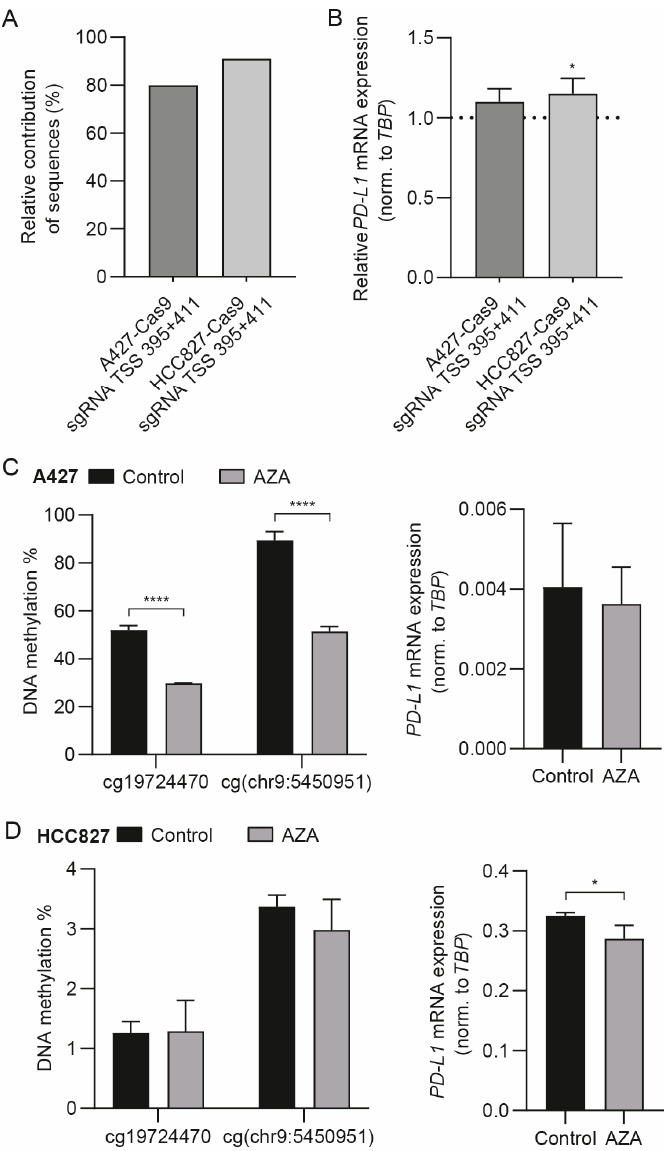
Figure 3. PD-L1 mRNA expression following alteration in genome-wide DNA methylation by aza- cytidine (AZA). (A,B) The consequence of a PD-L1 deletion harboring cg19724470 and cg(chr9:5450951). (A) The relative contributions of sequences with the deletion of both cg19724470 and cg(chr9:5450951). (B) PD-L1 mRNA expression normalized to TBP followed by normalization to cells transduced with the control sgRNA. The do tt ed line represents normalized expression with the control sgRNA. Mean ± SD of technical triplicates. (C,D) E ff ect of 48 h of AZA treatment on PD- L1 mRNA expression and methylation in (C) A427 cells and (D) HCC827 cells. Mean ± SD of tech-